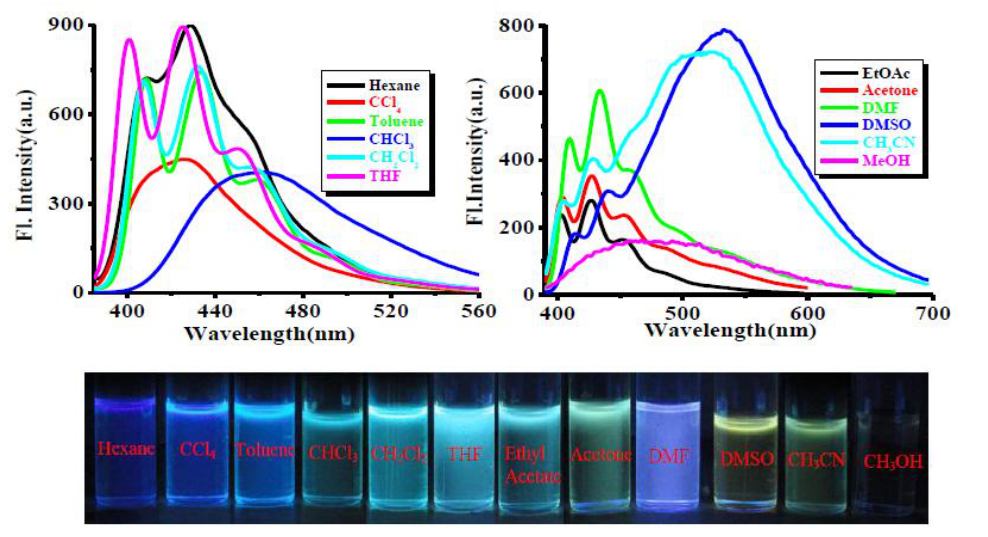
Figure 20: Comparative fluorescence spectra of compound 33 in different solvents at 1x 10 - 5 M (up) and their naked-eye flurescence change under hand held UV lamp (down) (adapted from ref. 57).